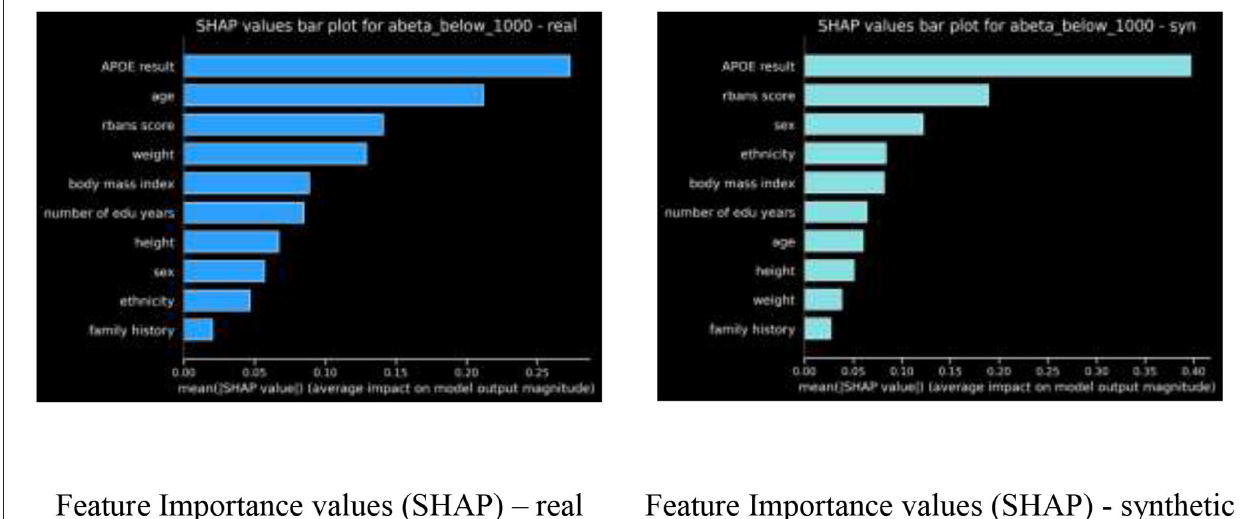
FIGURE 4 | Feature importance using SHAP values compared.